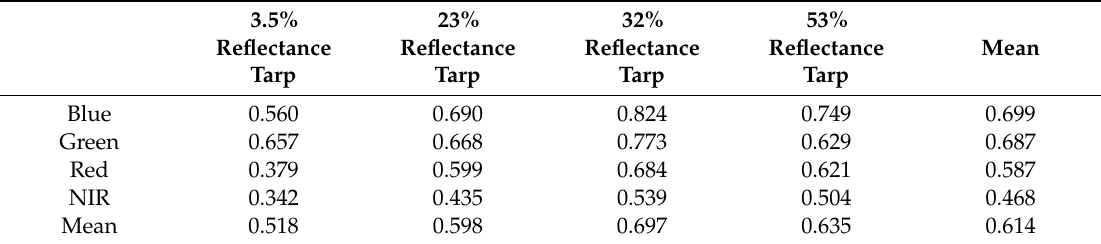
Table 11. TOA radiance uncertainty due to atmospheric simulations (unit: